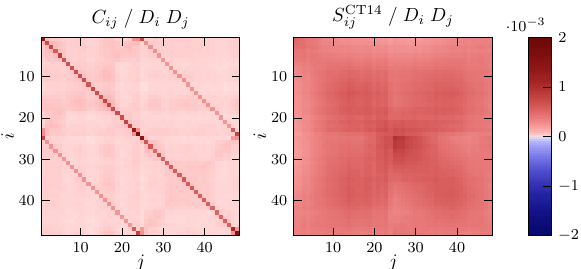
Fig. 1 Lepton-rapidity differential W ± production cross sections in p+Pb collisions at 8.16 TeV with a breakdown of the theoretical uncer- tainties (EPPS16 × CT14, light-blue boxes) into those from free-proton PDFs (CT14 NLO, yellow boxes) and from the nuclear modifications